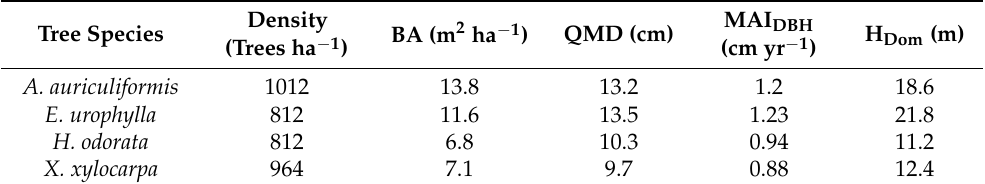
Table 1. Stand characteristics of each 11-year-old plantation, including stand density, basal area (BA), quadratic mean diameter at breast height (QMD), mean annual increment of stem diameter (MAI DBH ), and top height (H Dom